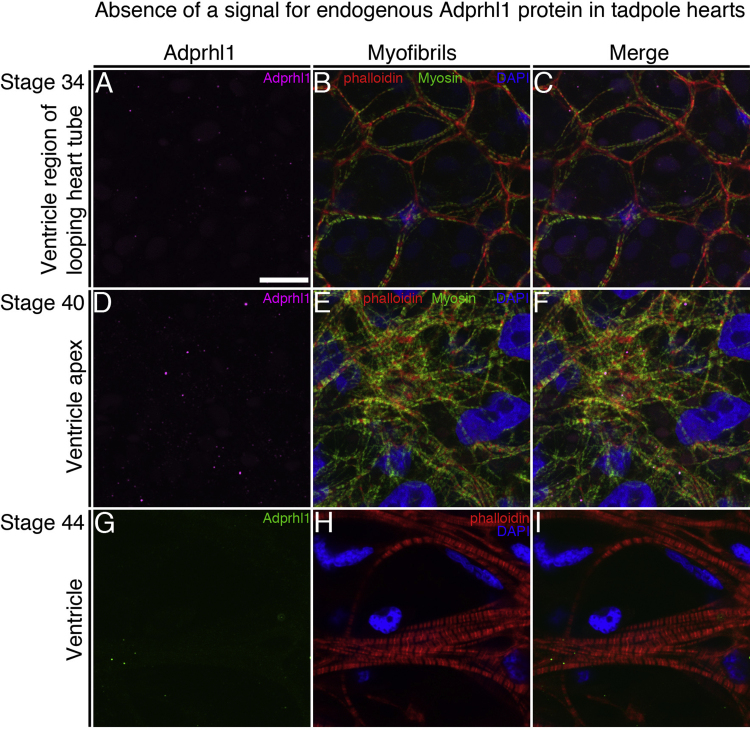
Absence of a signal for endogenous Adprhl1 protein in tadpole hearts. Despite the mRNA for adprhl1 being an abundant molecule in embryonic hearts, endogenous levels of Adprhl1 protein are low and are not readily detected by immunocytochemistry. Scarce fluorescent dots observed using the Adprhl1 antibody can be detected in superficial optical sections of all embryonic tissues and are not specific. A–C: Cardiomyocytes in the ventricular region of a looping stage 34 heart tube. A: Anti-Adprhl1, using a far-red channel, fluorescent secondary antibody. B: Phalloidin, anti-myosin heavy chain and DAPI. C: Merge of four channels. D–F: Similar sequence of images of cardiomyocytes from the apex of the ventricle at stage 40. G–I: Stage 44 ventricular cardiomyocytes, this time using a different green channel, fluorescent secondary antibody to attempt Adprhl1 detection. Scale bar (A)=10 µm and applies to all images.